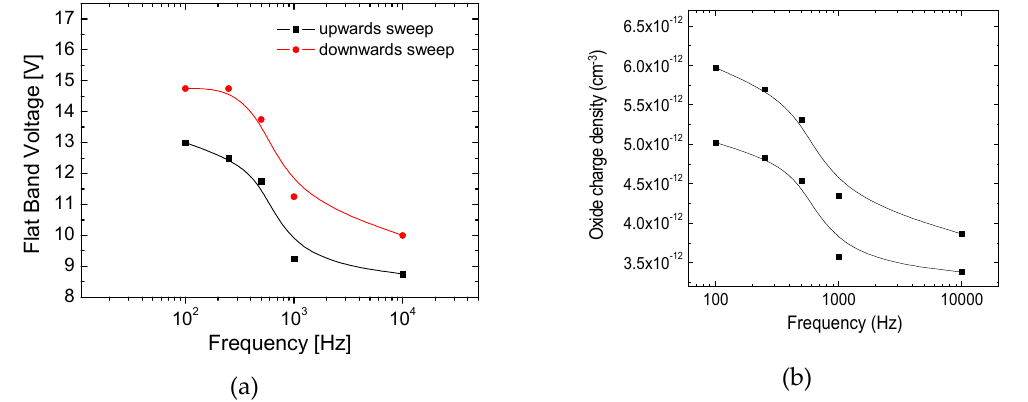
Figure 6. ( a ) Flat band Voltage dependence on the frequency; ( b ) Oxide charge density as a function of the frequency. The upper curves correspond to the upwards sweep while the lower curves to the downwards sweep (see Figure 5b).